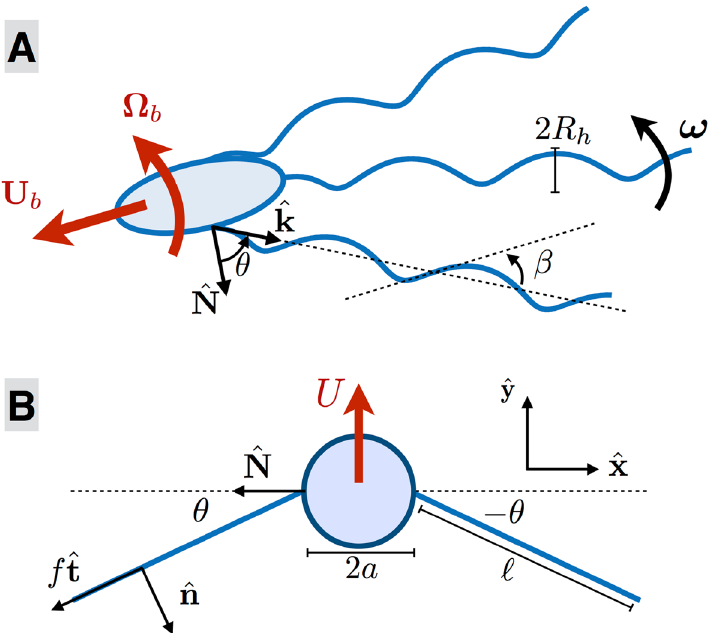
Figure 2. ( A ) Computational model of a peritrichous bacterium actuating N f helical filaments (radius R h ; pitch angle β ) by rotating them about their axis ˆ k with prescribed angular velocity. The flexible hook acts elastically to align the helix axis with the normal ˆ N to the cell body. ( B ) Simplified model to capture the elastohydrodynamic instability. Two straight active filaments of length  attached on either side of a spherical body of radius a are tilted at an angle ± θ away from the cell body surface normal, N ˆ , and act on the cell with tangential force  f t ˆ resulting in swimming of the model bacterium with velocity ˆ U y